Question: Write the caption for this figure.
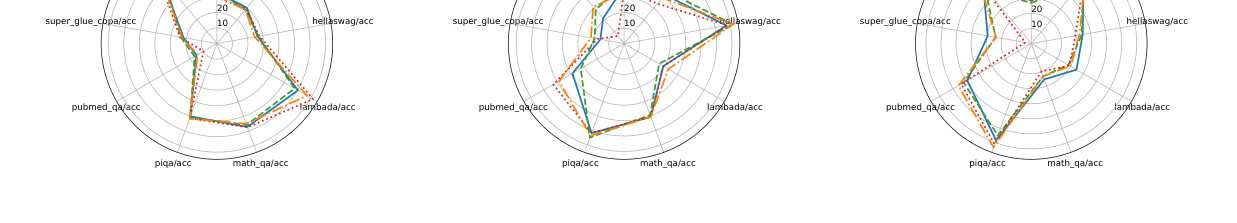
Answer: The average accuracy scores across nine language reasoning tasks. From left to right: unlearning 8 samples, 16 samples, and 32 samples at once, respectively. Results based on the 125 million checkpoint.